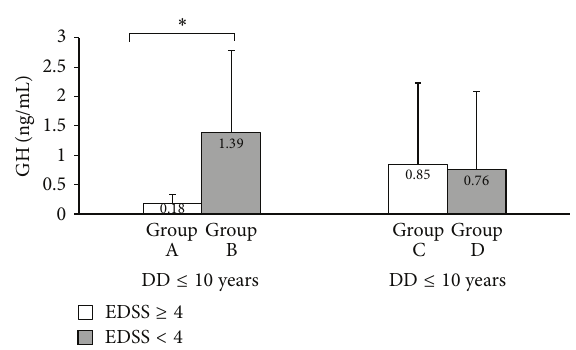
Figure 1: Serum GH levels in MS patients according to disease duration and EDSS score. Values are expressed as mean ± SD; ∗ 𝑃 < 0.05 (nonparametric test Mann-Whitney 𝑈